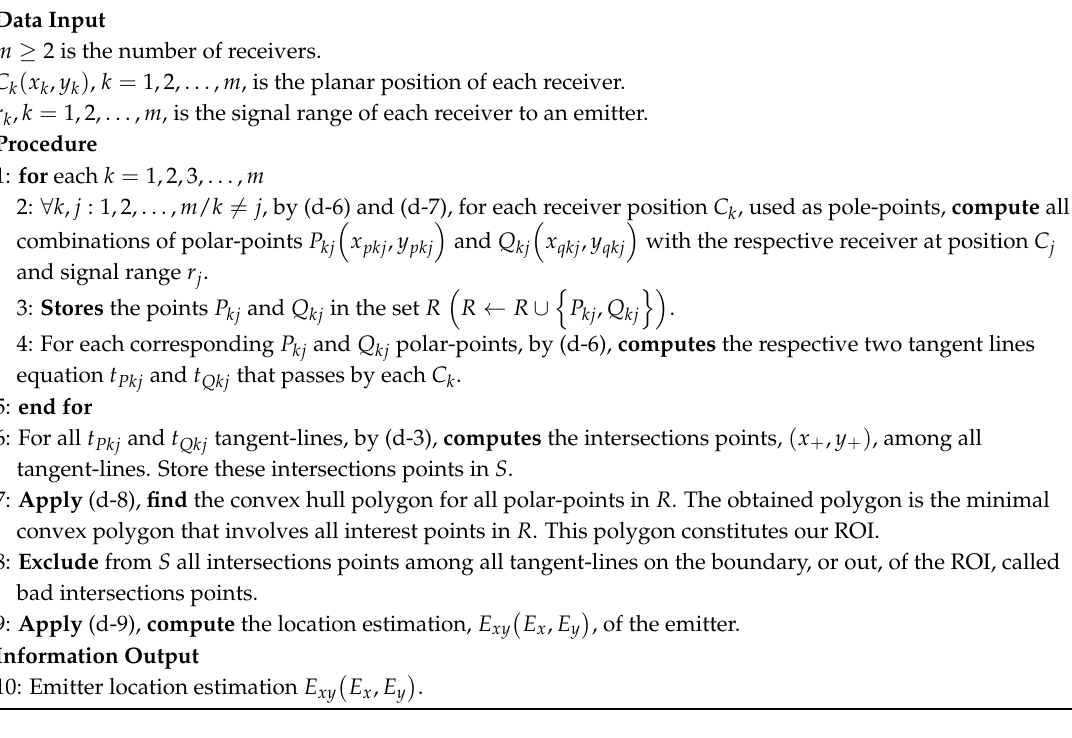
Algorithm 4. TLI—Tangent Lines Intersections Model Algorithm Data